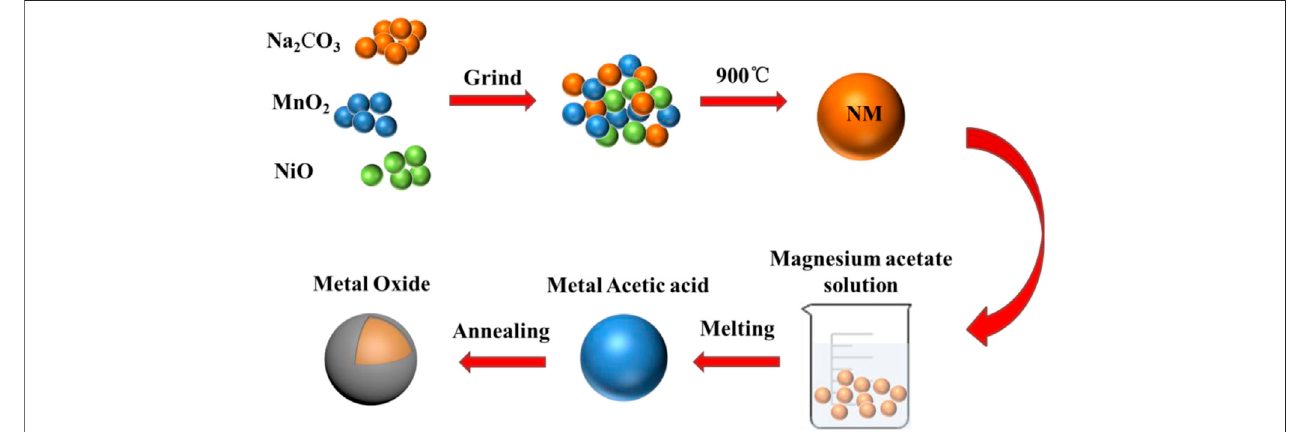
FIGURE 1 | Schematic diagram of MgO-coated NM cathodes.